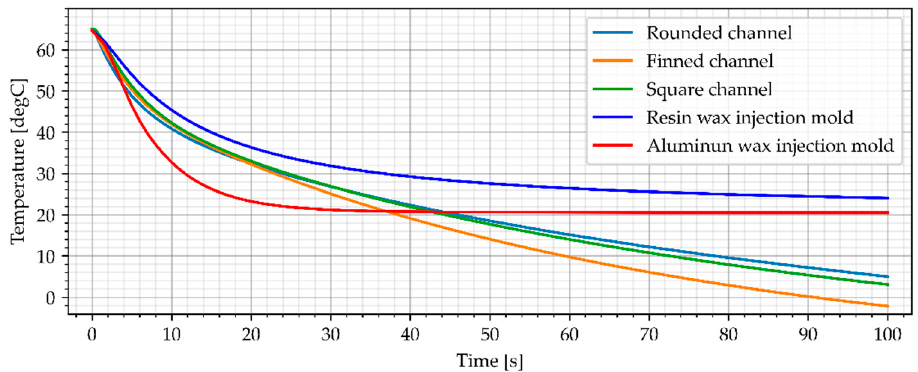
Figure 21. The average temperature of the sample.